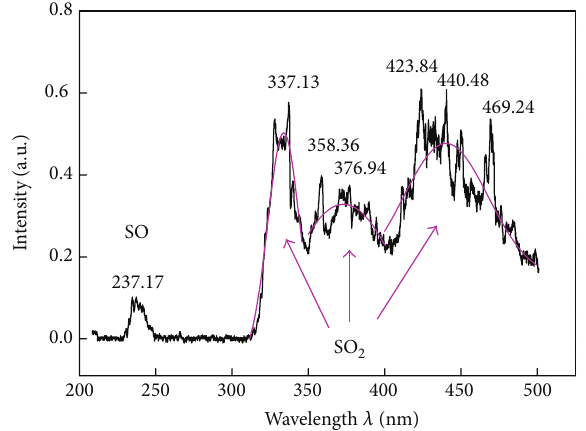
Figure 2: The emission spectra detected from the pulse discharge SO 2 removal system in the wavelength range from 200 to 500